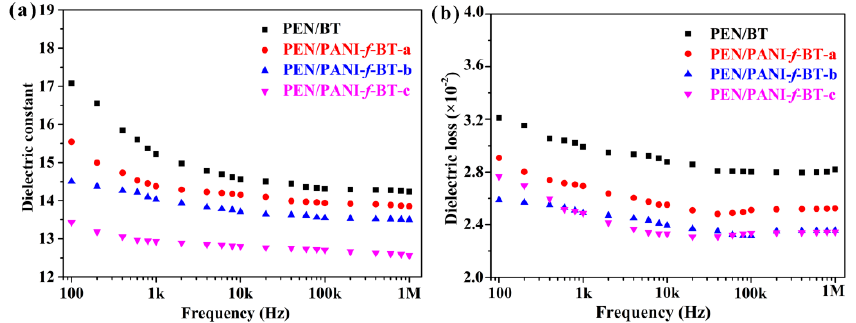
Figure 9. ( a ) Dielectric constant and ( b ) dielectric loss of the nanocomposites with the changing of frequency.